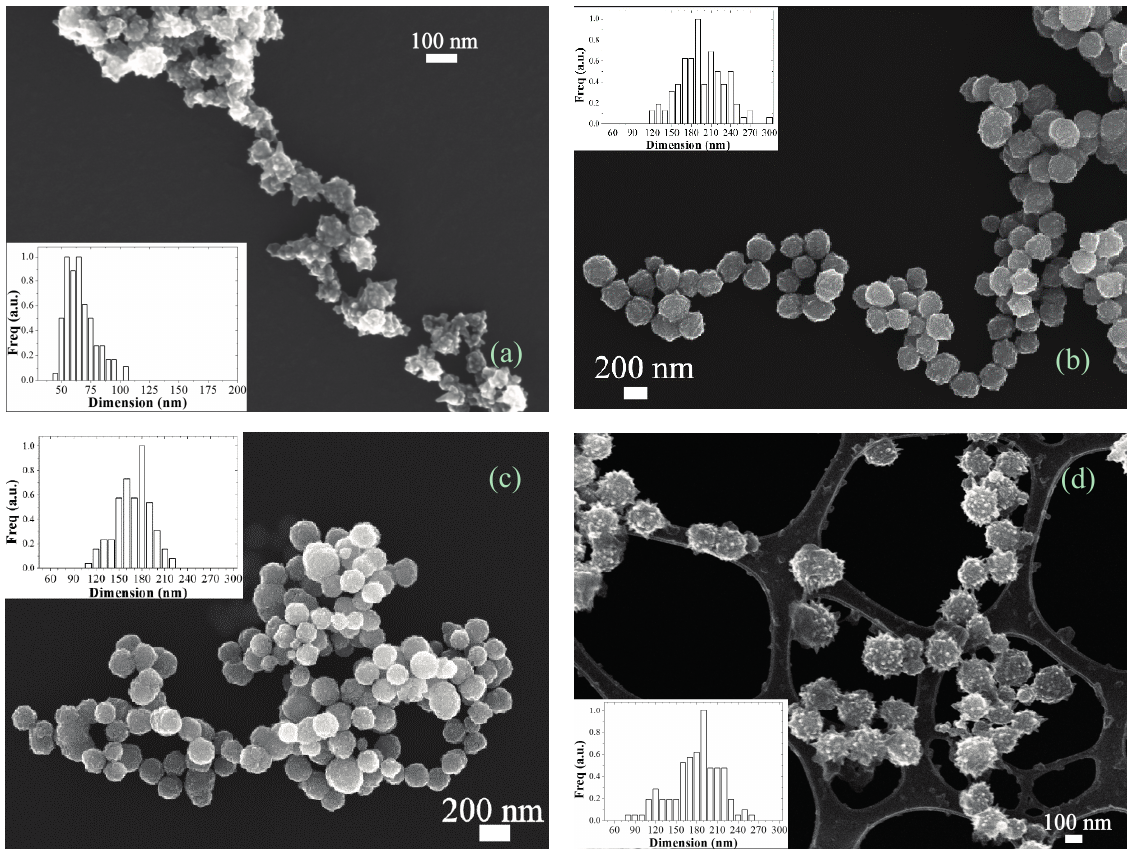
Figure 4. SEM images of samples S1 ( a ); S2 ( b ); S3 ( c ) and S4 ( d ) together with the correspondent diameter distribution. Table 2. Top: Some of the synthesis parameters applied in the experimental trial. Bottom: some product characteristics are reported. (d SEM : diameter determined from SEM images, SD: standard deviation, CV %: percentage coefficient of variance, d XRD : diameter from